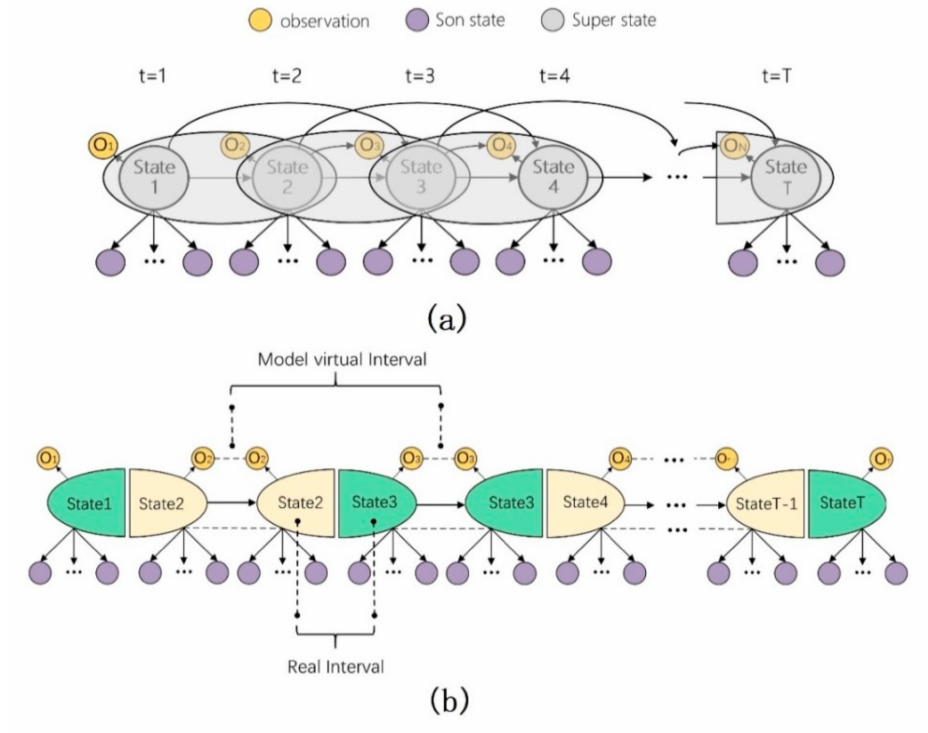
Figure 2. The illustration of the model reduction based on permutation. ( a ): Division of compound nodes; ( b ): Markov chain model with reduced order after compound